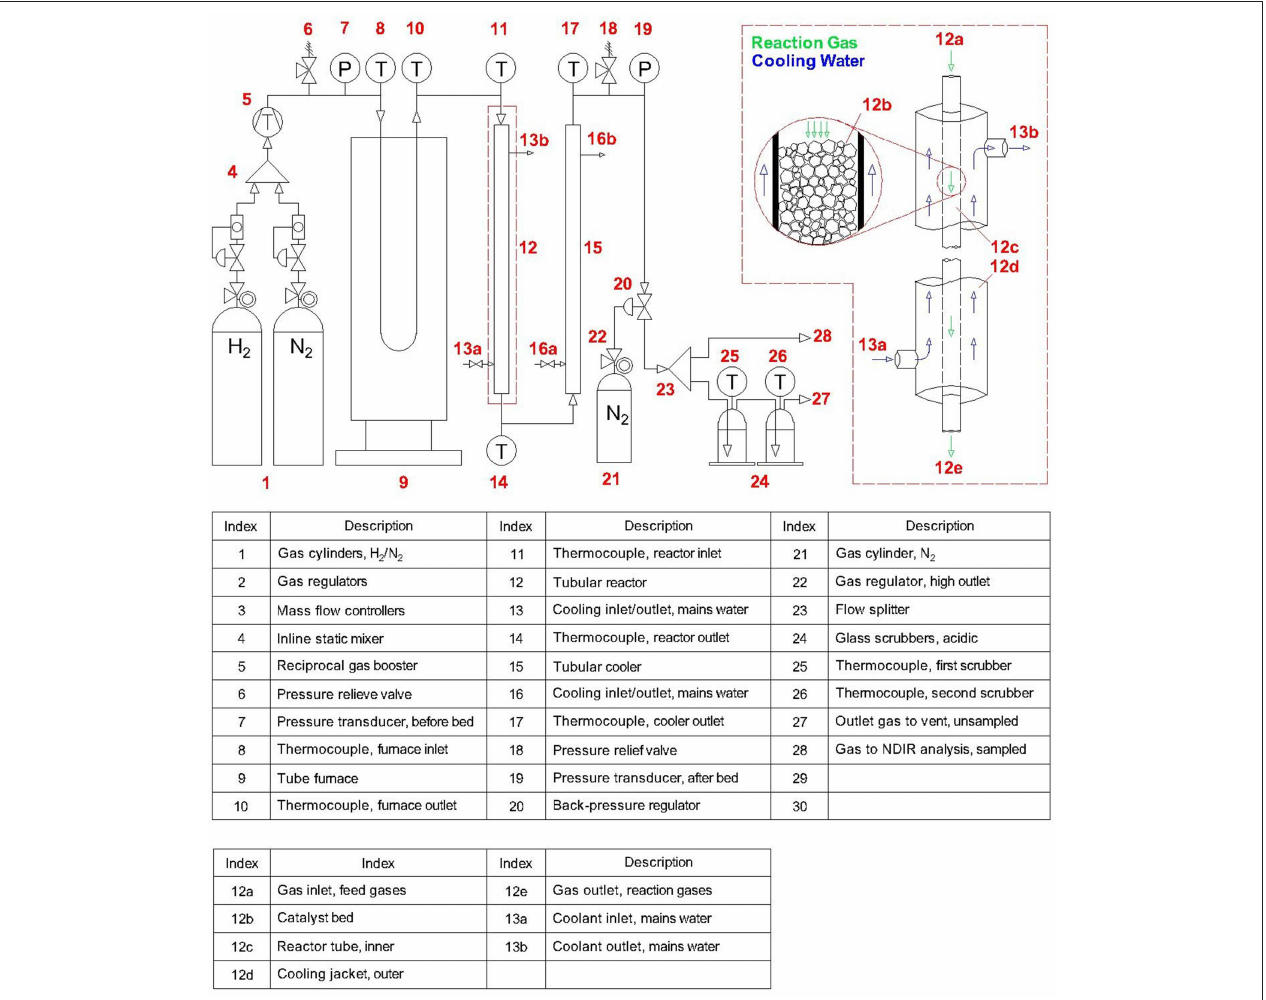
FIGURE 1 | Experimental configuration used throughout synthesis of